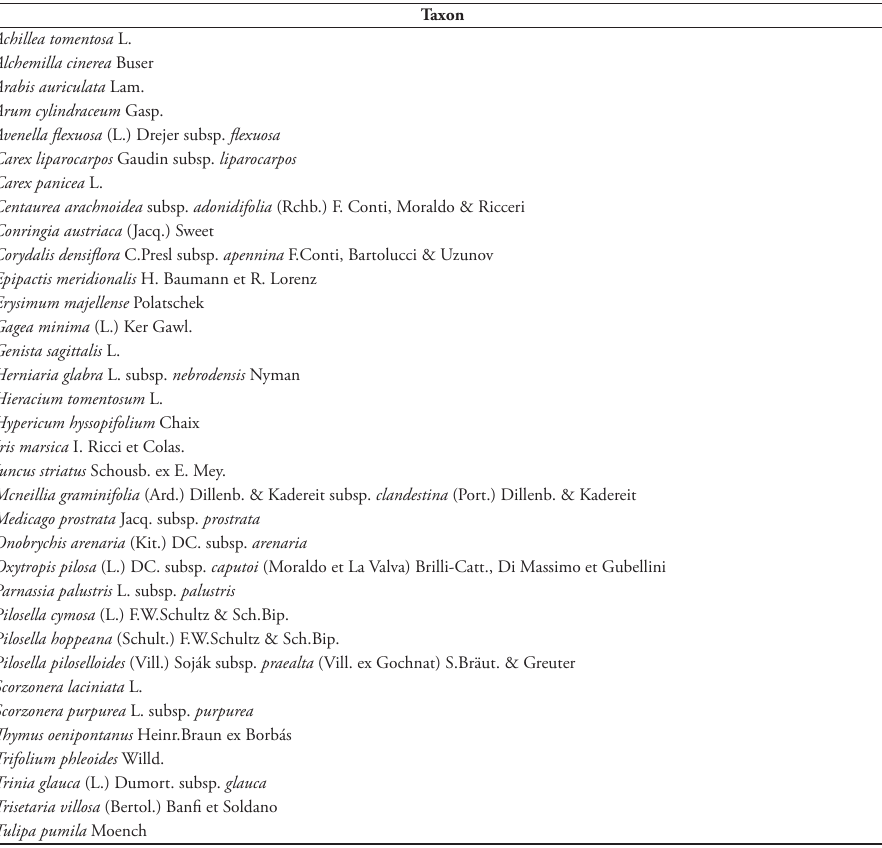
Table 2. List of taxa found in the study area considered very rare (RR) at regional level including those that are new records for Lazio with respect to Anzalone et al.